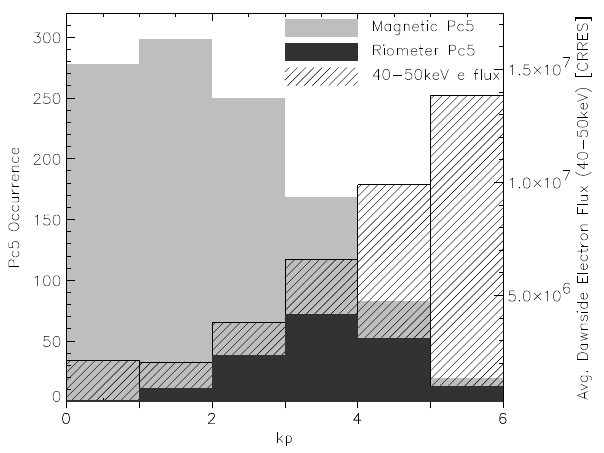
Fig. 6. Number of magnetometer (light grey) and riometer (dark grey) Pc5 pulsation events binned according to K p . Also shown is the average dawnside (5–13 MLT) 40–50keV electron flux at 5 <L< 9 from the CRRES satellite.